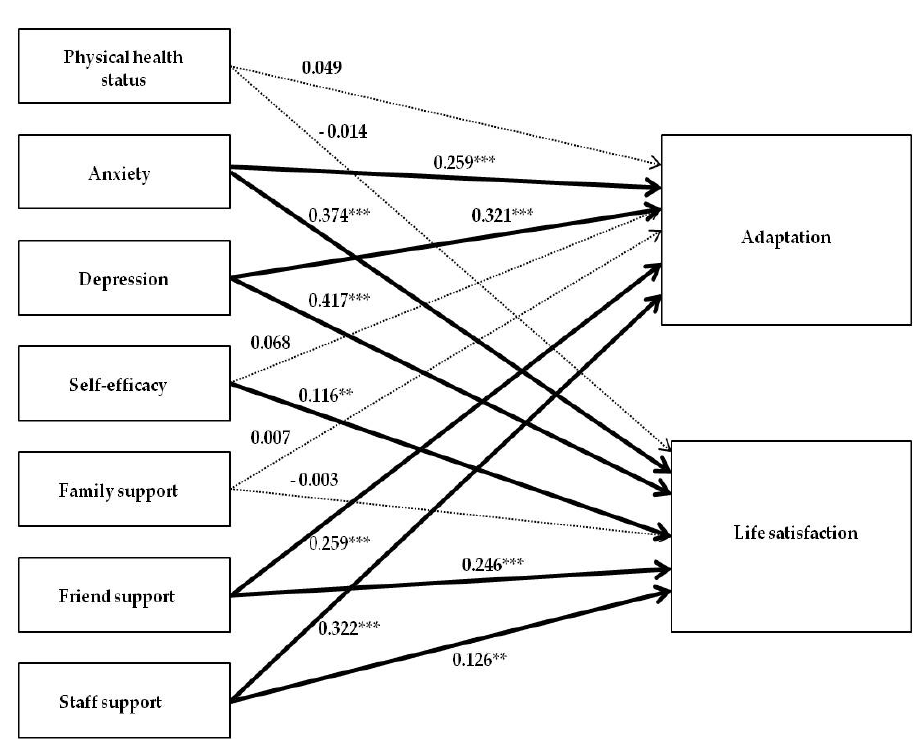
Figure 2. The hypothetical model.